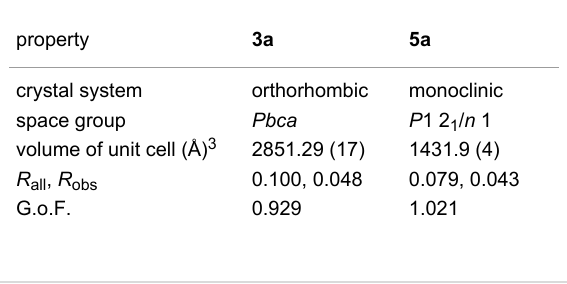
Table 2: Key crystallographic data for oxime 3a and amide 5a , representative substrate and product of the Beckmann rearrangement (Scheme 1, Figure 1) [18].